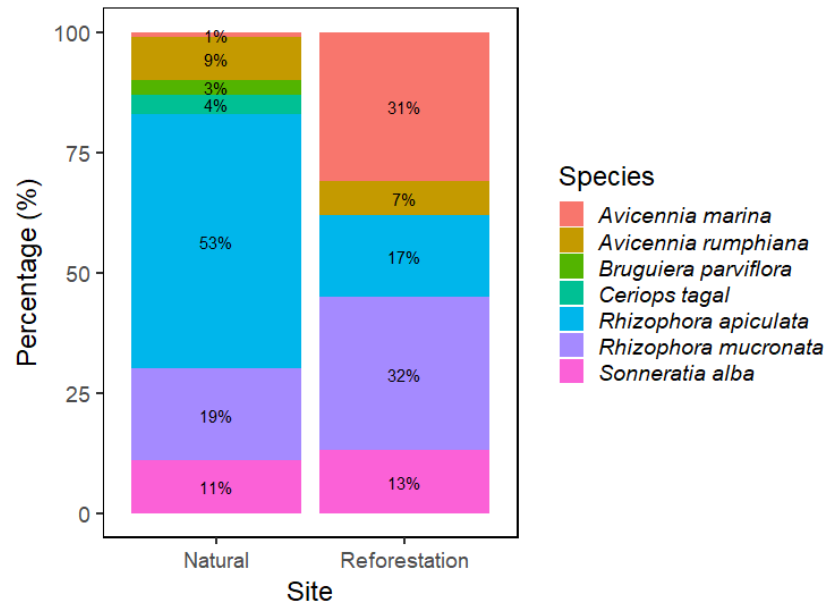
Figure 3. Percentage distribution of species existing in the natural and reforestation sites based on the number of trees recorded during the measurement.